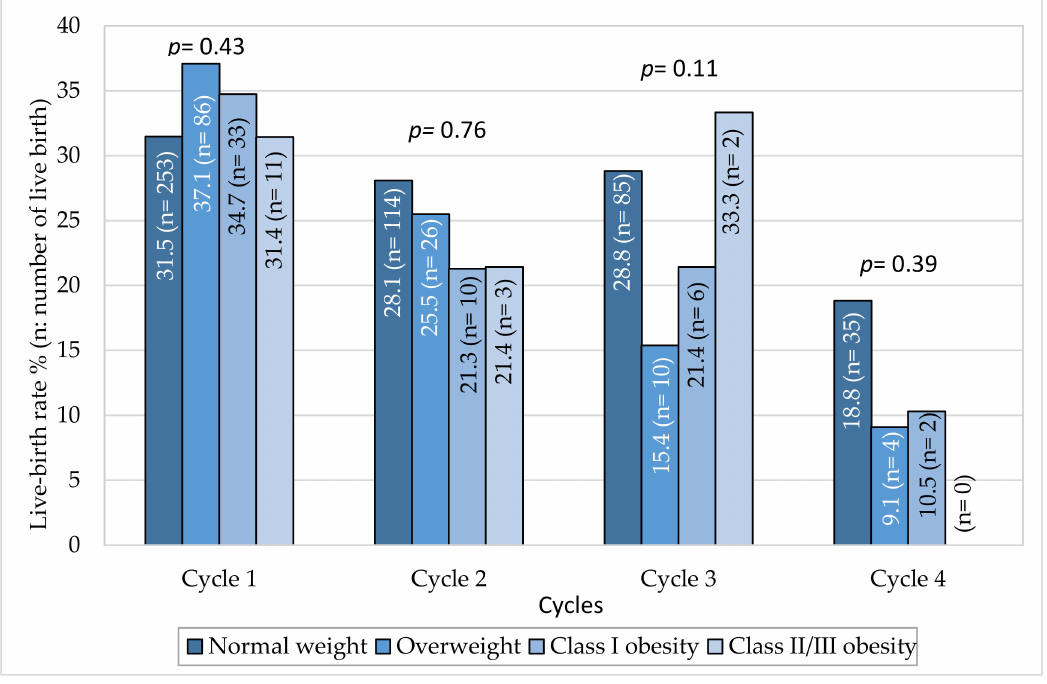
Figure 2. Live-birth rate by cycle and BMI